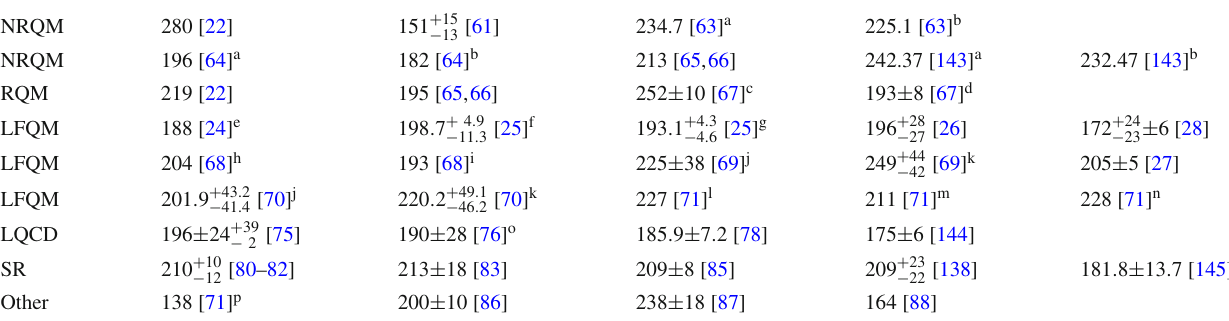
(in the unit of MeV), where the legends are the same as those in Table 3 u